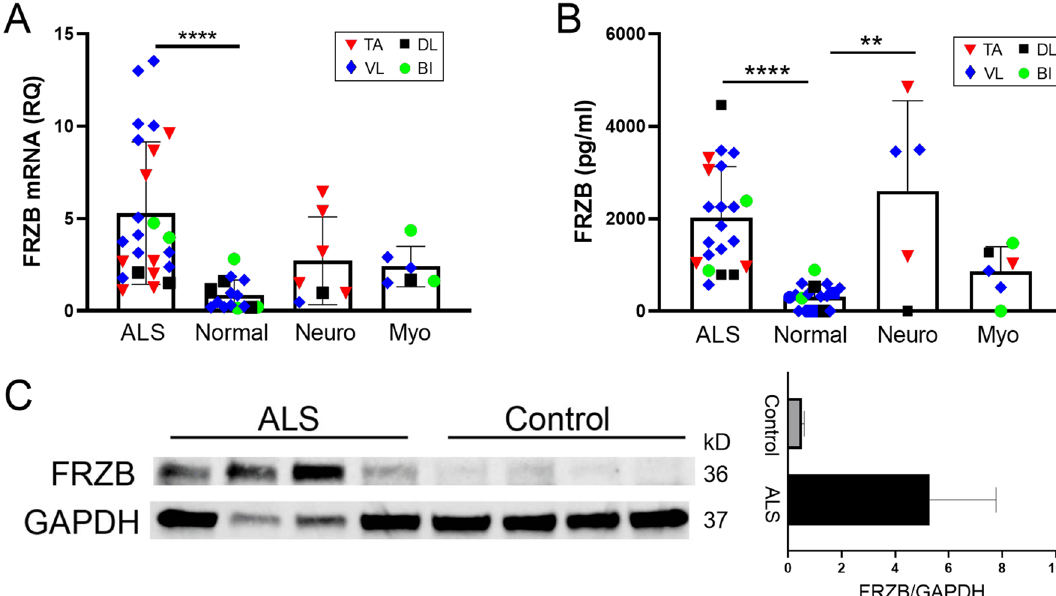
Figure 1. FRZB is upregulated in ALS muscle tissues. ( A ) FRZB mRNA expression in muscle was quantitated relative to GAPDH endogenous control using qPCR. Mean FRZB mRNA expression in normal control samples (n = 15) was set to 1. Mean values (± SD) for FRZB mRNA in ALS (n = 24), myopathy (n = 6), and neuropathy (n = 7) were expressed as fold-change over normal control. ****P < 0.0001. ( B ) FRZB protein expression was quantitated in muscle lysates using ELISA. Mean (± SD) FRZB protein concentrations (pg/ml) for normal control (n = 18), ALS (n = 21), myopathy (n = 6), and neuropathy (n = 5) are shown. *P < 0.5; ****P < 0.0001. ( C ) Left panel: western blot comparing FRZB expression in vastus lateralis muscle samples from ALS and normal control subjects using GAPDH as a loading control. Full blots are shown in Supplemental Fig. S1. Right panel: Quantitation (mean ± SD) of FRZB protein levels estimated by densitometry and normalized to